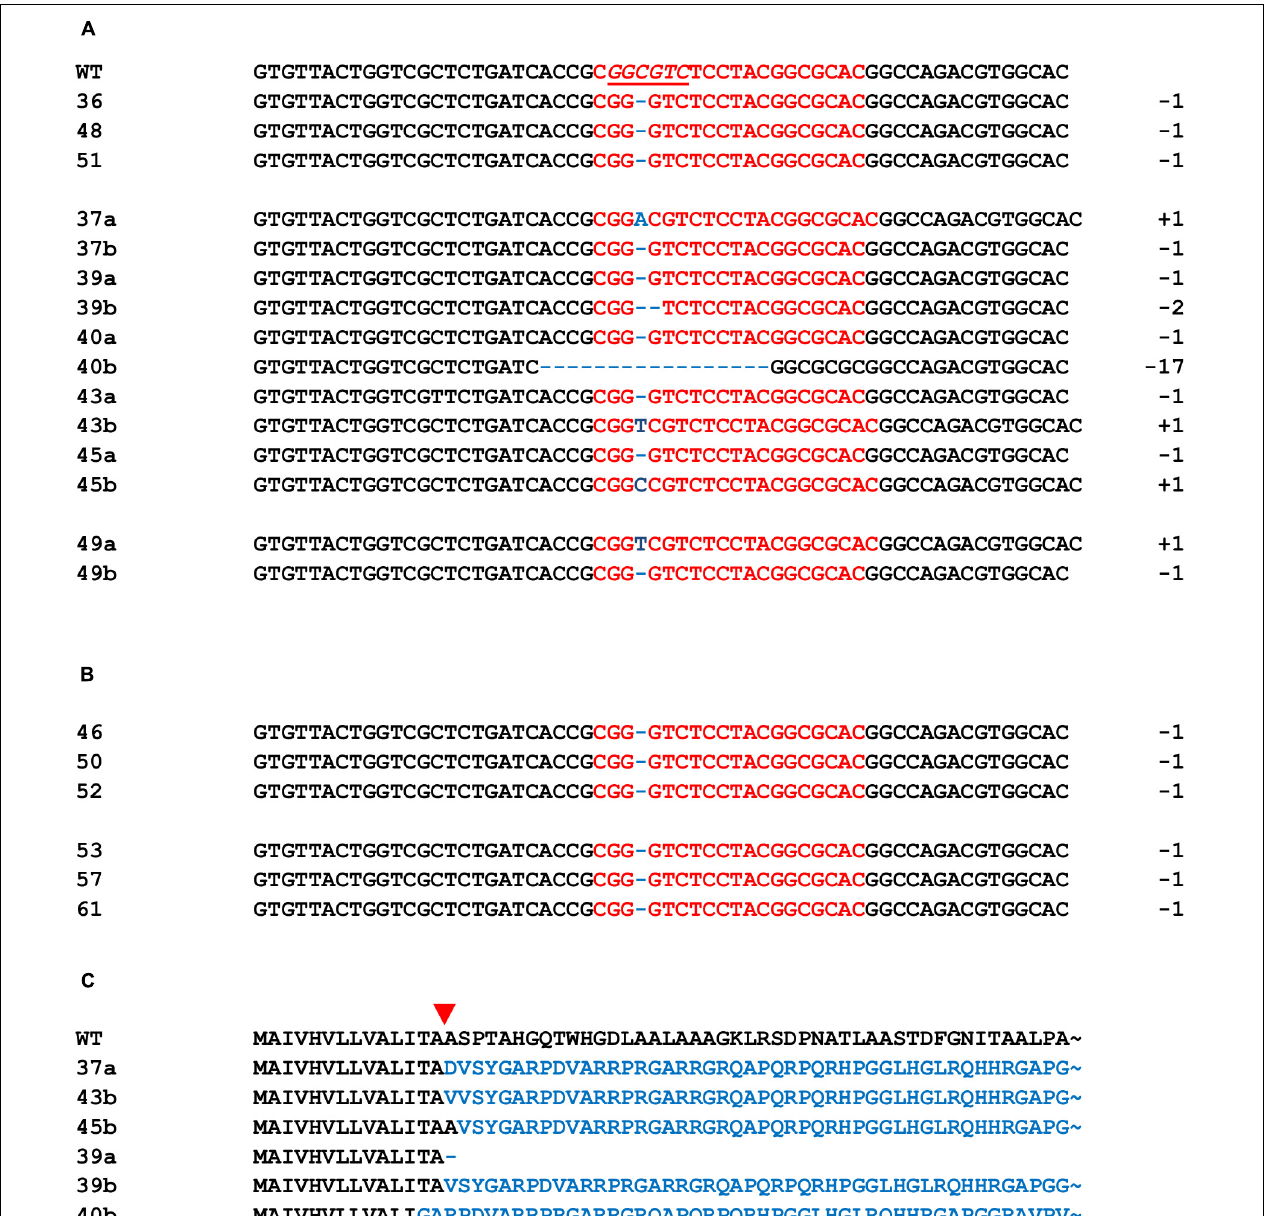
FIGURE 2 | Modification of HvCKX1 sequence induced by the KO-CKX1 construct in primary transgenic mutant plants. HvCKX1 sequence alignment of the nine mutants, where the mutation occurred in both alleles (A) ; six mutants, where the mutation occurred in one allele (B) and WT HvCKX1 sequence. Deduced amino acid sequences of the mutant proteins (C) . The red sequence represents the Cas9 target site and underlined italics sequence represents Bsa HI restriction site. The number of nucleotides deleted (dashed) or inserted (blue color) is shown to the right side of each sequence. The names of the lines are shown to left site of each sequence, where (a) and (b) of the lines 37, 39, 40, 43, 45, 49 represent two different sequences occurred. The red triangle indicates the DSB induction